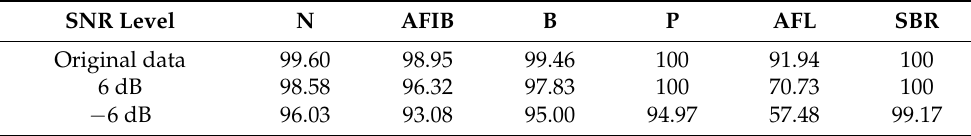
Table 9. Effect of noise in ECG signals on the performance of the proposed